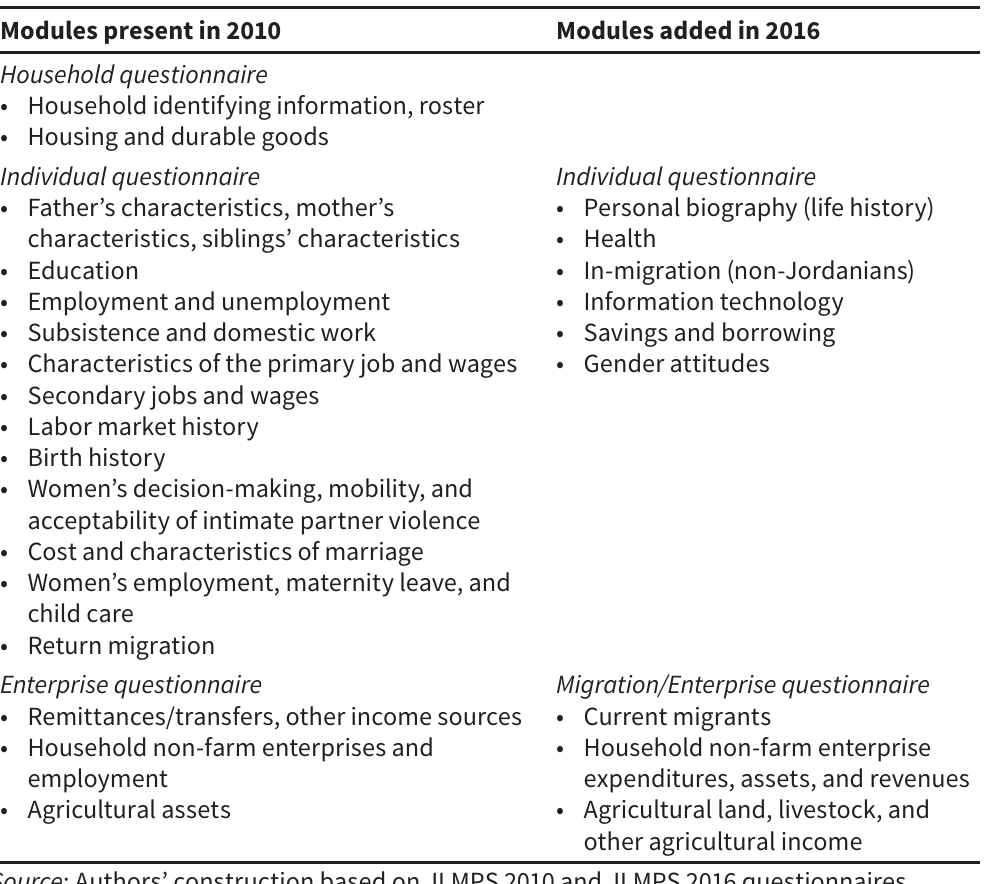
Table 1 Modules of the questionnaire in 2010 and 2016 Modules present in 2010 Modules added in 2016 Household